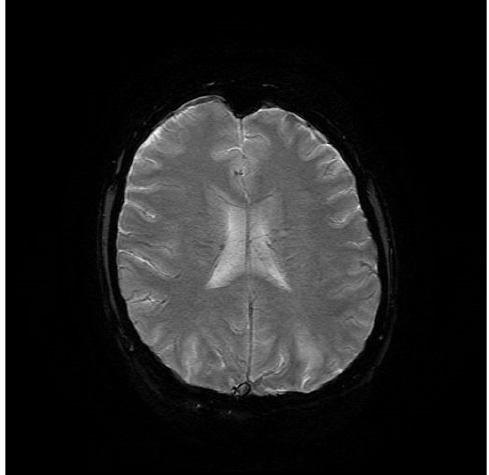
Figure 3. T2-WI MRI sequence of the brain in transverse plane.